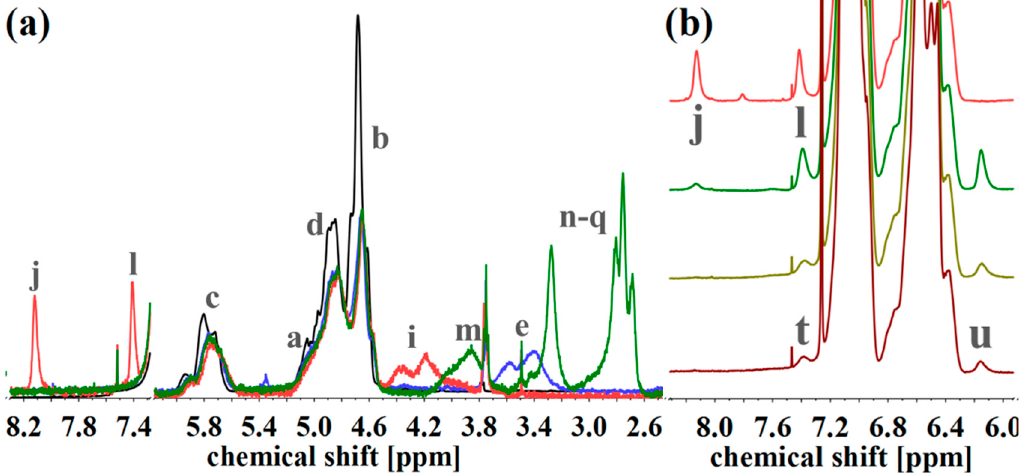
Figure 8. ( a ) 1 H NMR spectra of S 85 I 1551 (black), after hydroxylation (blue), and after reaction with CDI (orange) and DETA (green) in CDCl 3 . ( b ) 1 H NMR spectra of CDI ‐ functionalized S 85 I 1551 (top), and after addition of DAP with reaction times of 7 h, 3 d and 4 d (from top to the bottom) in CDCl 3 . 1 H NMR spectra were normalized to aromatic protons of PS (6.2–7.2 ppm, 5H).